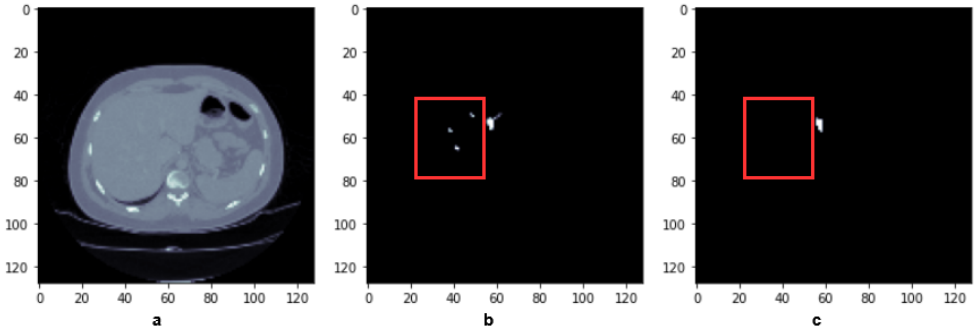
Figure 9. Portal vein sample 2: ( a ) image, ( b ) original mask and ( c ) predicted mask without zooming in the